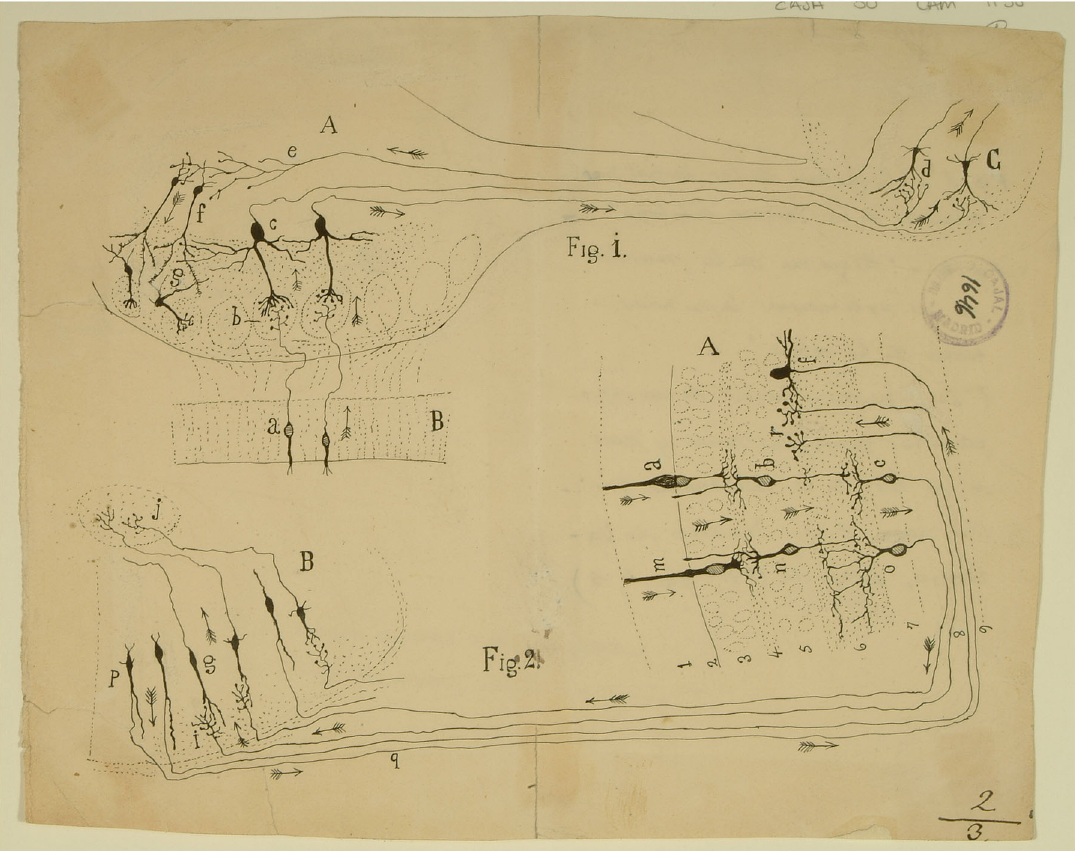
Fig. 1 Ramón y Cajal ’ s drawing of nerve impulses corresponding to the olfactory and visual systems. Note the arrows that indicate the neuronal fl ow in a scienti fi c illustration that introduces dynamic polarization, a hypothesis for functional analysis of the brain that remains relevant today. This fi gure is not covered by the Creative Commons Attribution 4.0 International License. Reproduced with permission of Juan A. De Carlos; copyright © Cajal Institute ( Centro Superior de Investigaciones Cientí fi cas , CSIC), all rights reserved.